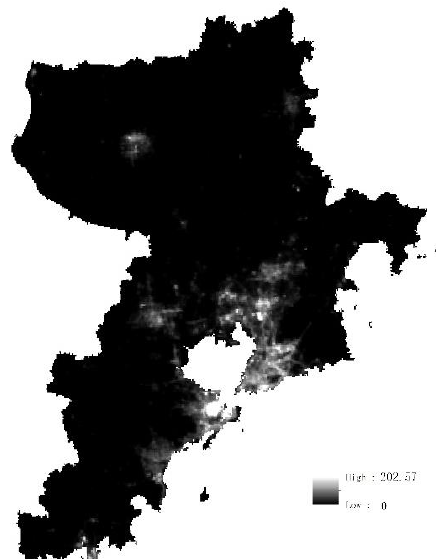
Figure 2. NPP_VRIIS nighttime light data in Qingdao